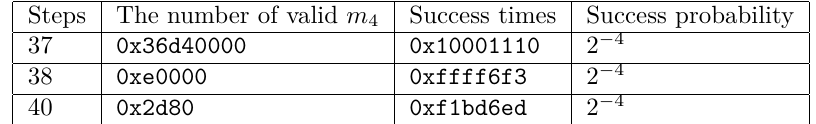
Table 11: Experimental